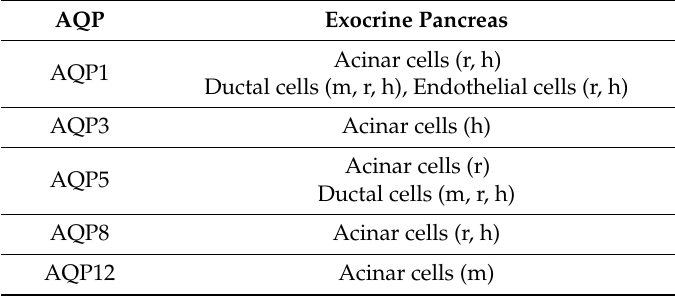
Table 3. AQPs expression in exocrine